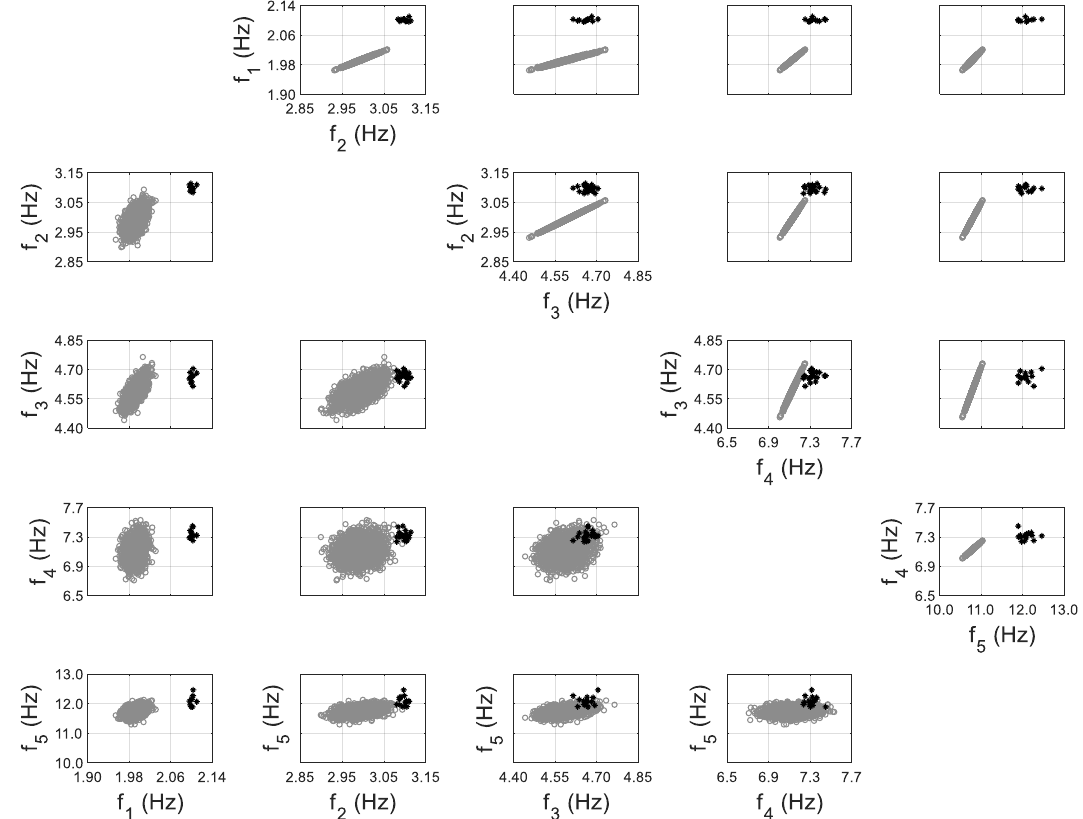
Figure 12. Model-predicted (gray) vs. identified (black) natural frequencies of the 10-story building at severe damage state, considering non-zero-mean error function for 5th mode (upper triangular subplots denote predictions without error function considered; lower triangular subplots denote predictions with propagation of error function).